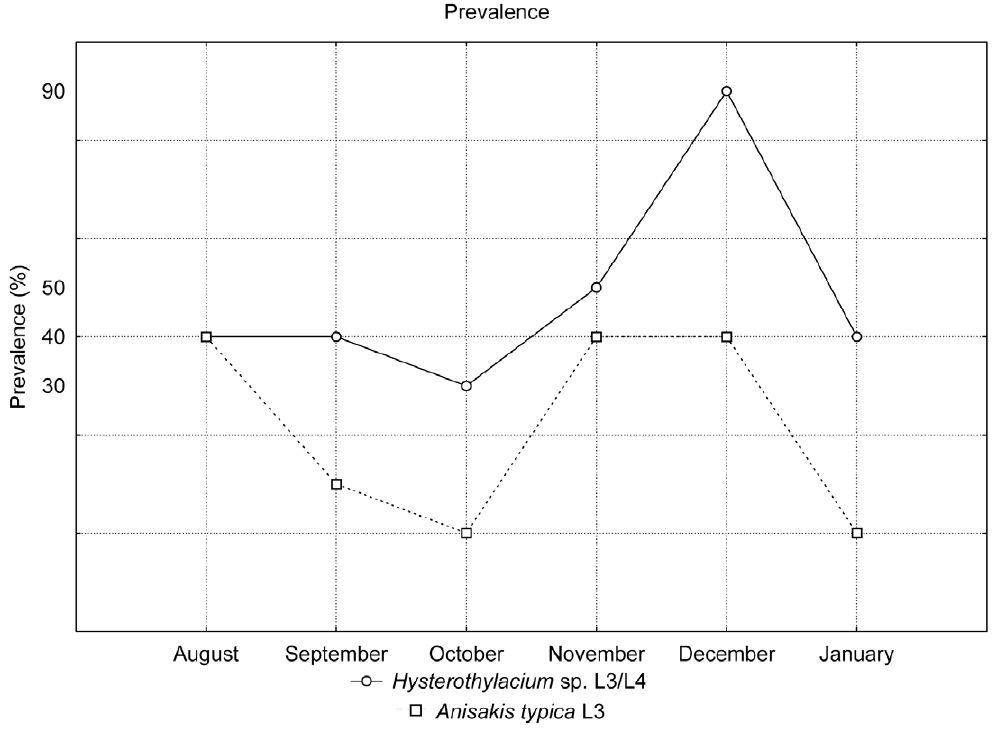
Figure 9. Ecological data of Anisakistypica and Hysterothylacium sp.: prevalence expressed as a percentage.